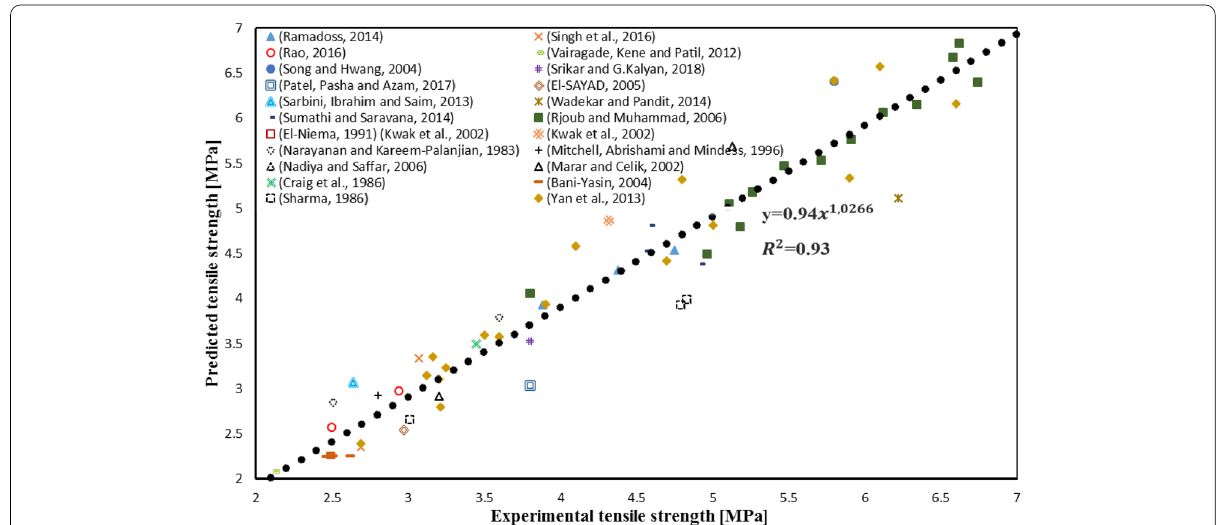
Fig. 5 Correlation of predicted splitting tensile strength with the experimental splitting tensile strength.